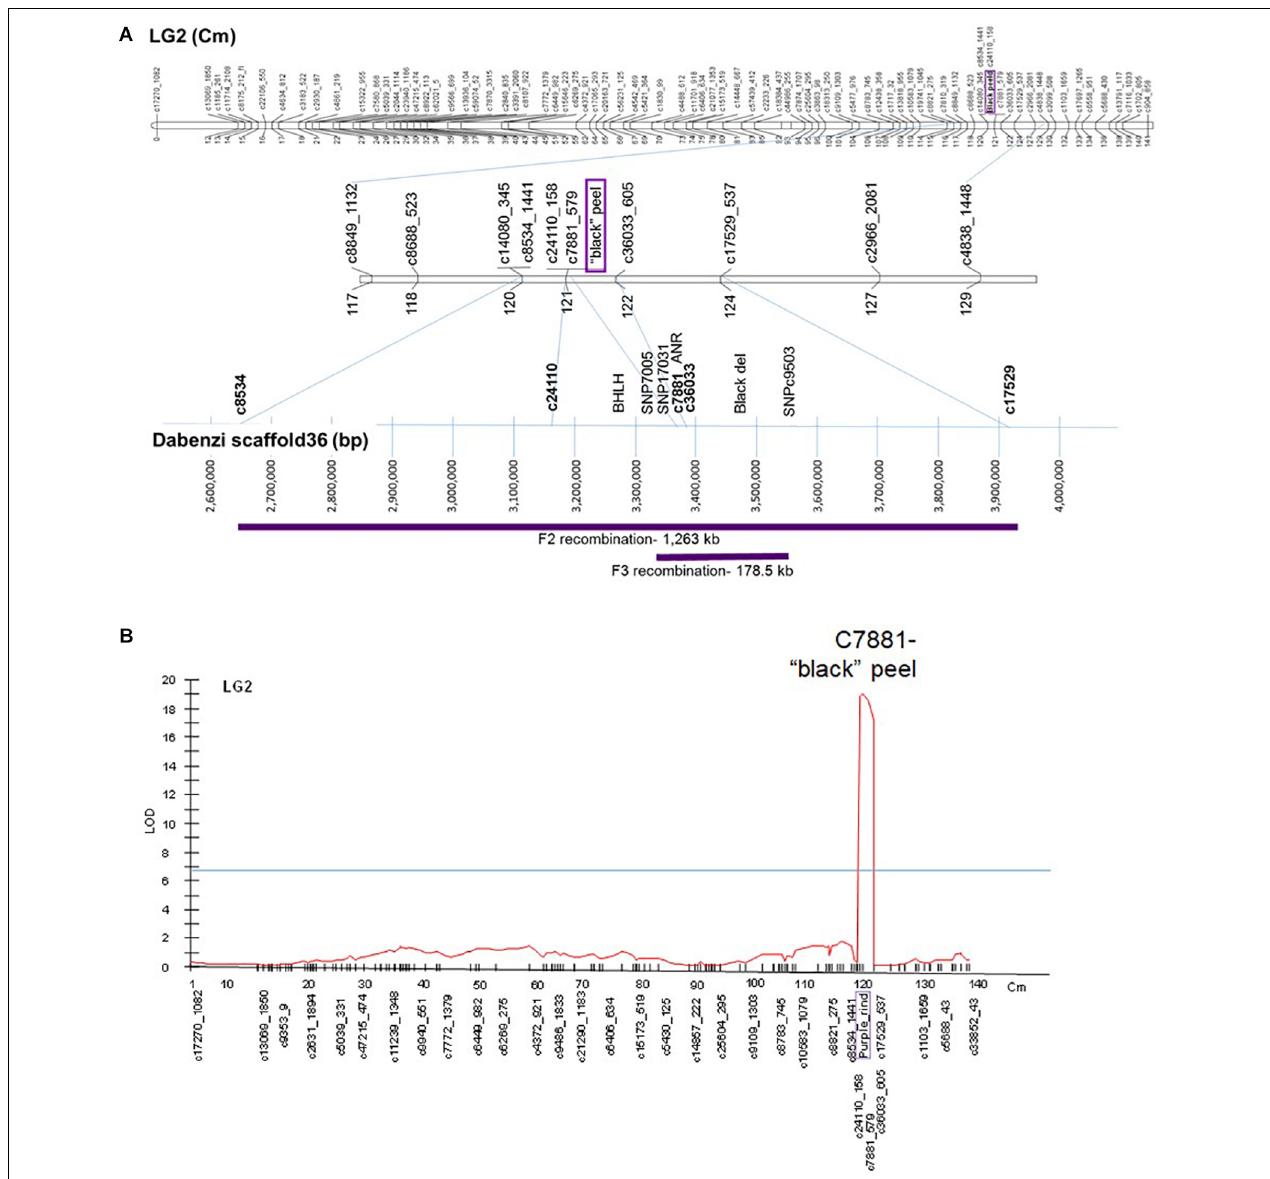
FIGURE 6 | Mapping the “black” trait in pomegranate. (A) On top - The “black” trait (in purple) was mapped to LG2 on the published ‘Nana × Black’ F 2 genetic map (Harel Beja et al., 2015). At the bottom - Positioning of the mapped genetic markers and additional markers on the published sequenced genome (‘Dabenzi’ scaffold36; Qin et al., 2017). The regions on the genome corresponding to the F 2 and F 3 recombinations are in purple. (B) QTL analysis (MQM) of total anthocyanins for the F 2 progeny at LG2.